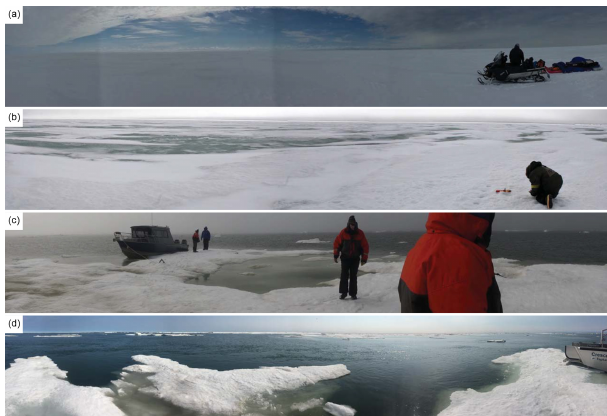
Figure 2. Sea ice in the vicinity of Utqia˙gvik, Alaska, USA, dur- ing summer melt. (a) Photomosaic of 8 May 2015 sample site (M- CS). (b) Panorama photograph of 7 June 2015 sample site (JN-CS). (c) Panorama photograph of the floe sampled on 11 July 2015 (JY- 11). (d) Panorama photograph of floe L2 sampled on 13 July 2017